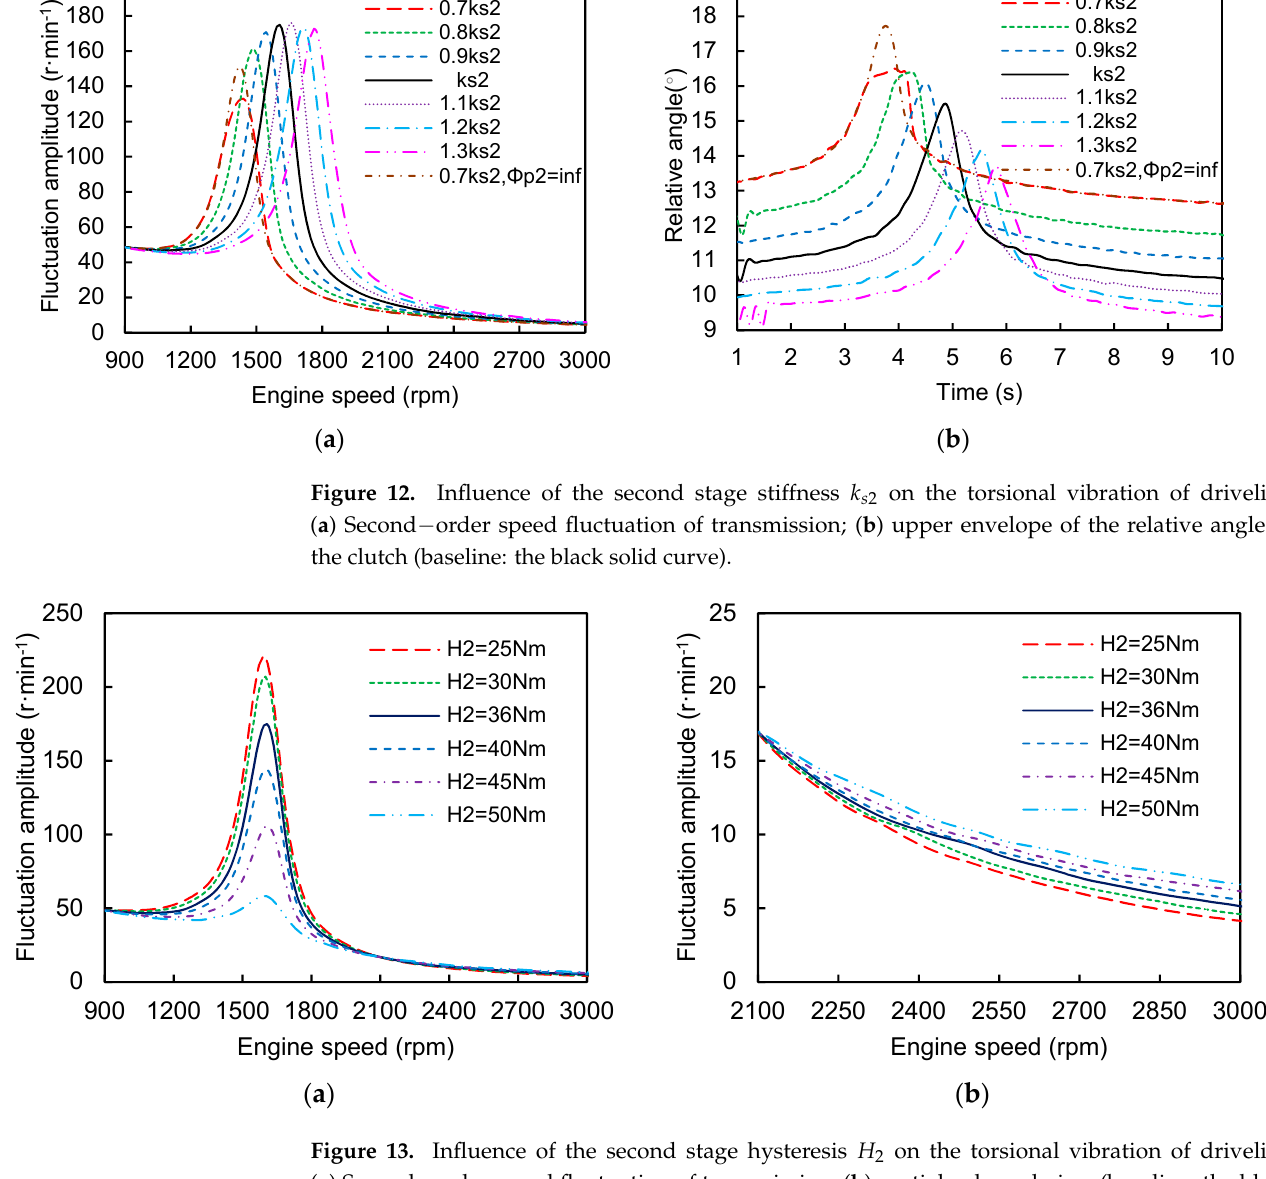
( a ) Second − order speed fluctuation of transmission; ( b ) partial enlarged view (baseline: the black